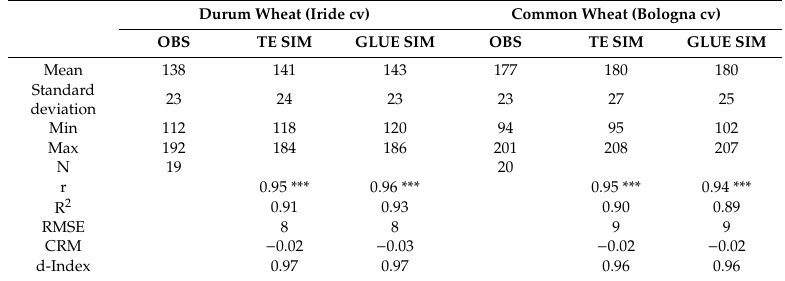
Table 11. Statistical results of observed (OBS) and simulated (SIM) values of anthesis date (in days after planting = dap) for durum wheat (Iride cv) and common wheat (Bologna cv) for the evaluation of CSM-CERES-Wheat model.